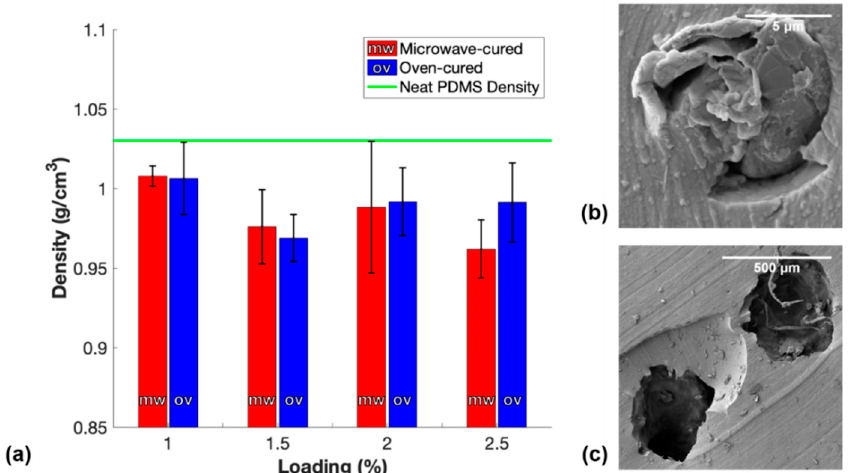
Figure 3. ( a ) Density measurements of conductive m-PDMS / CNT and t-PDMS / CNT samples, ( b ) SEM image of a pore within 1 wt.% m-PDMS / CNT, and ( c ) SEM image of pores within the lowest density 2.5 wt.% m-PDMS / CNT sample.